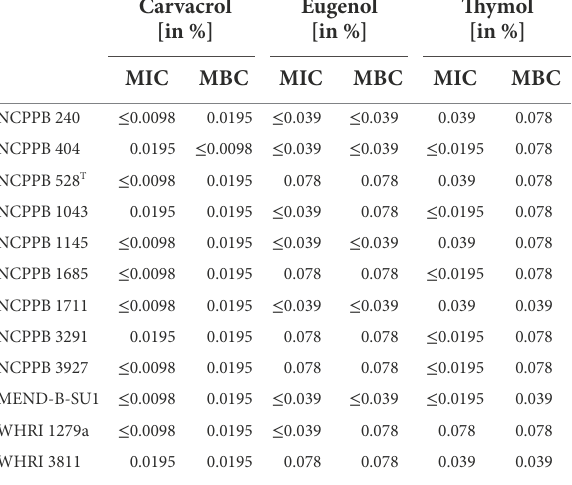
TABLE 3 Minimum inhibitory concentration (MIC) and minimum bactericidal concentration (MBC) values of carvacrol, eugenol and thymol solutions for 12 Xanthomonas campestris pv. campestris